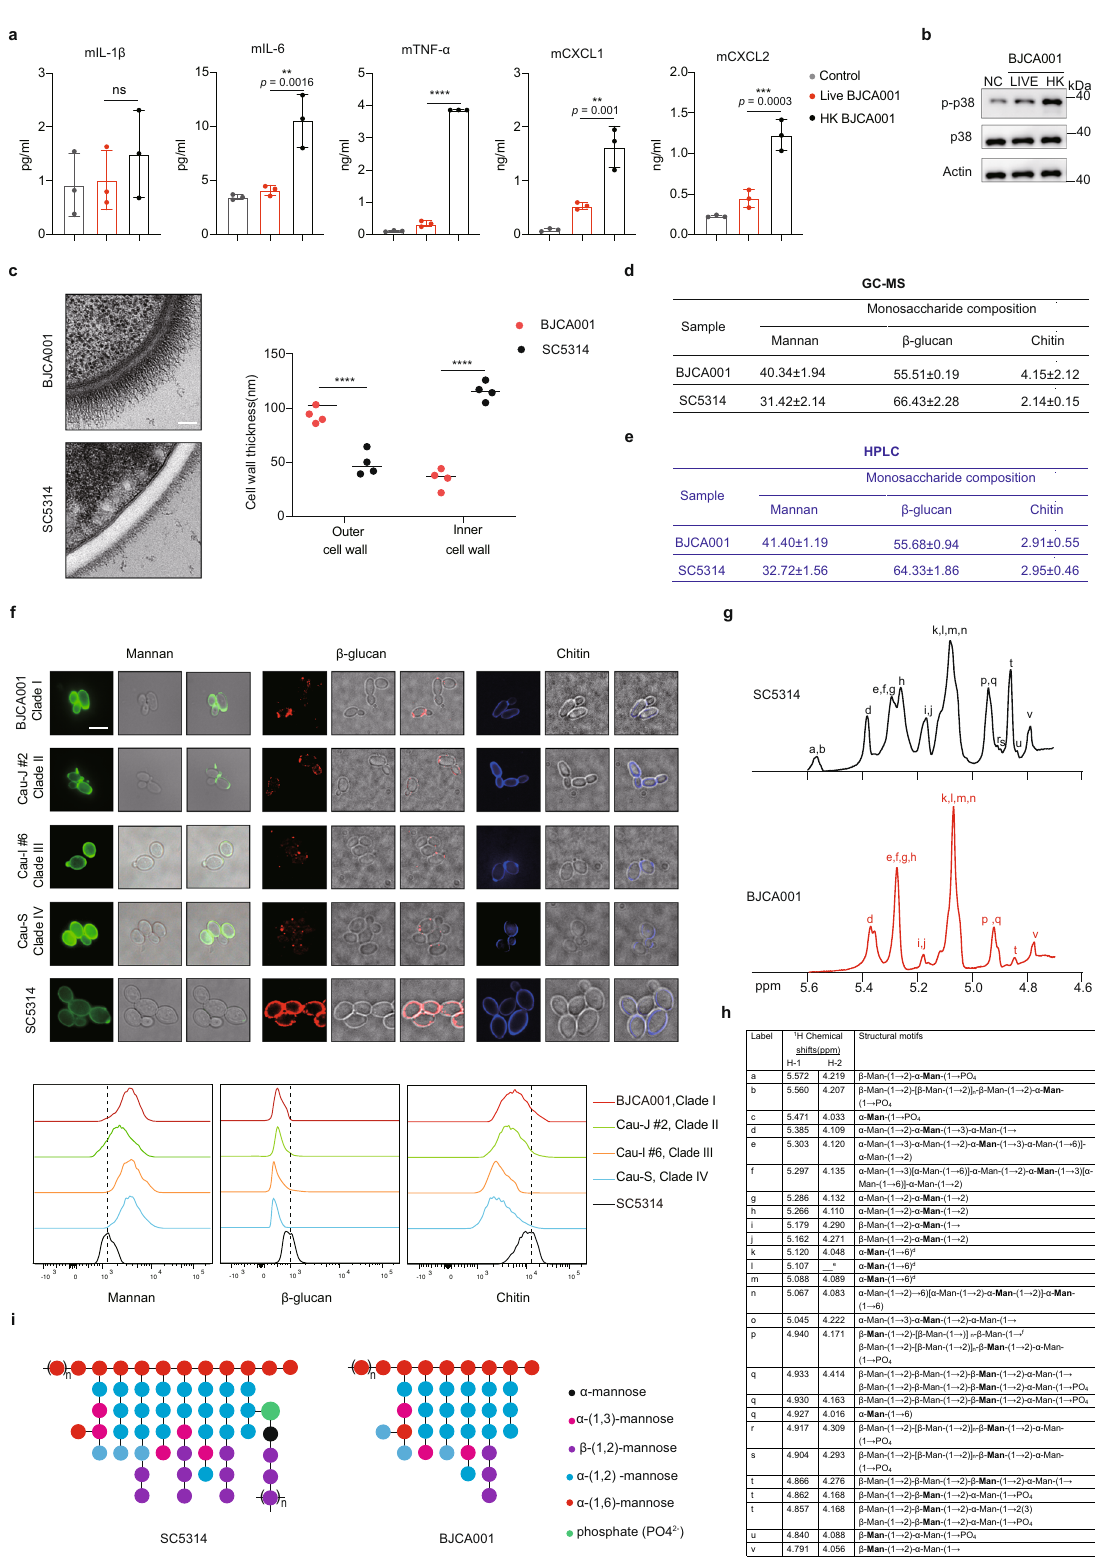
mononuclear cells (MNCs) 39,45 . Furthermore, we also found that MNN4 deletion had no effect on C. albicans pathogenicity because the mnn4 Δ / Δ mutant was equally virulent in mice compared to its wild-type counterpart (Supplementary Fig. 13h) 44 . Hence, the removal of phosphomanan in C. albicans through deletion of MNN4 , which mimics its de fi ciency in C. auris , may NATURE COMMUNICATIONS| (2022) 13:3553